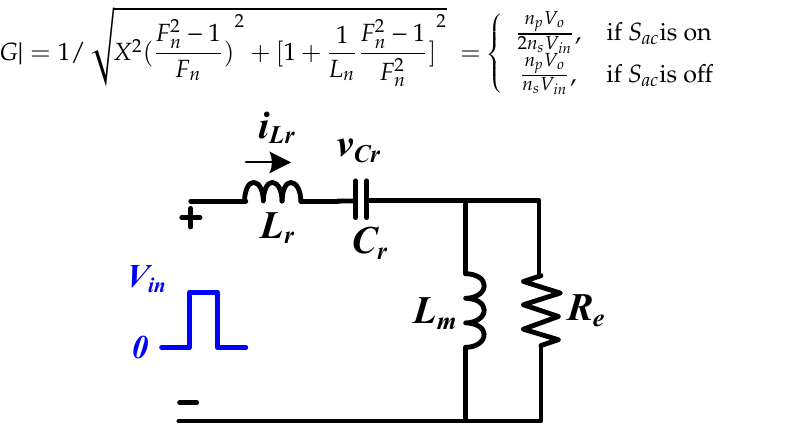
Figure 5. Alternating current (AC) equivalent circuit of the resonant tank.